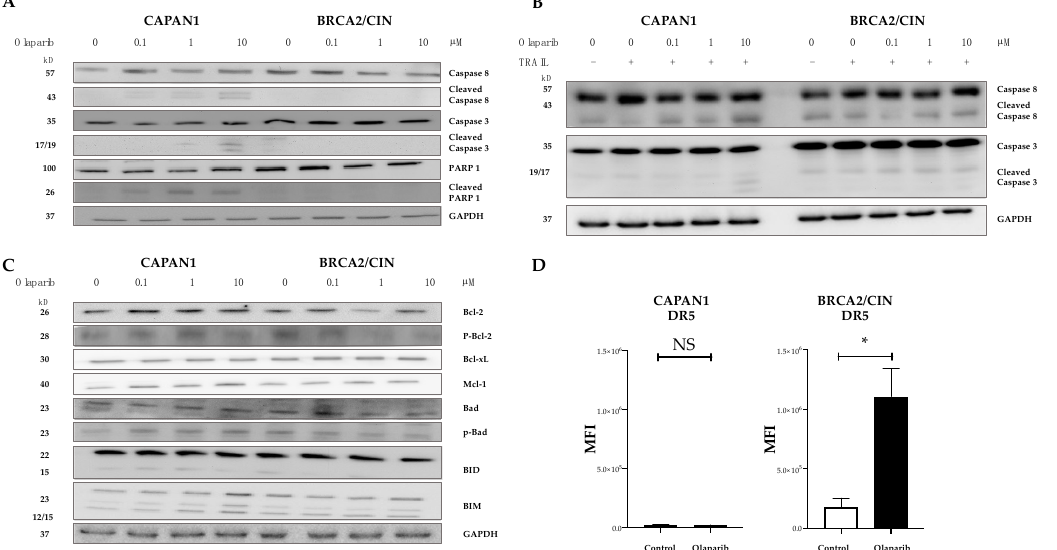
Figure 5. Olaparib influences death receptor expression and caspase activation. ( A – C ): Western blot analysis to assess the expression levels of the indicated regulators of apoptosis in BRCA2 deficient CAPAN1 vs. wild-type BRCA2 expressing BRCA2/CIN treated with various doses of olaparib alone or in combination with TRAIL (10 ng/mL) for 48 h. Data show representative results from three experiments. GAPDH served as a loading control. ( D ): Flow cytometry of TRAIL surface receptor 2 (death receptor 5, DR5) in BRCA2 deficient CAPAN1 vs. wild-type BRCA2 expressing BRCA2/CIN treated with 1 µ M olaparib for 6 days. Error bars represent mean ± SEM from at least three experiments. * = statistical significance, p < 0.05, NS = non-significant, MFI = median fluorescence intensity.